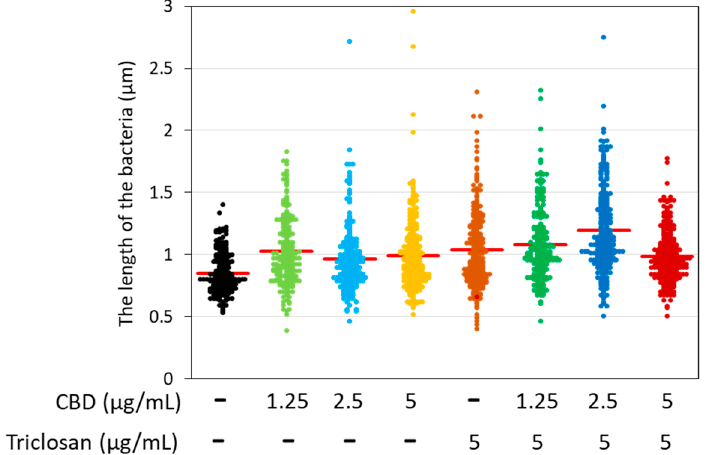
Figure 7. The length of the bacteria after a 2 h incubation with the indicated concentrations of triclosan and CBD as measured by ImageJ on 3–4 independent high-resolution scanning electron microscope (HR-SEM) images. N = 220–240 bacteria for each treatment. The red line shows the average bacteria length. The treated bacteria are significantly longer than the control bacteria ( p < 0.05).